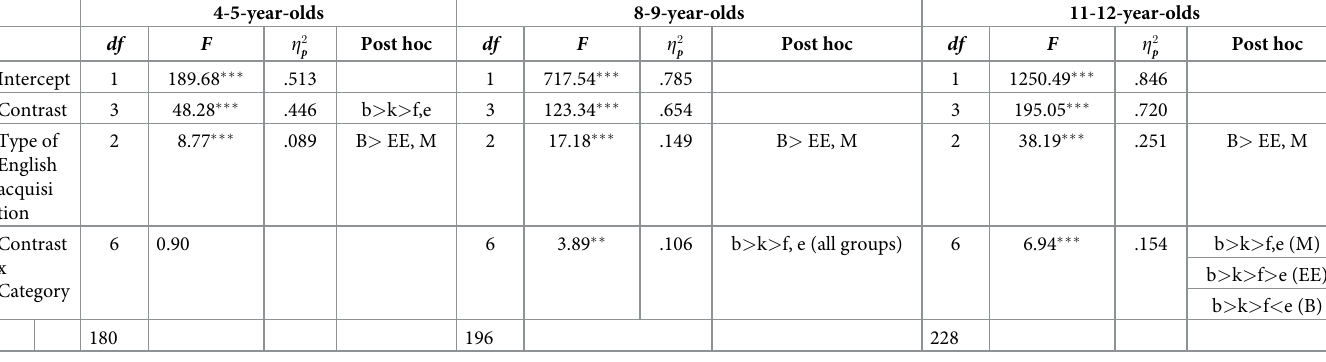
Table 3. ANOVA on d’ scores by contrast (Within-subject) and type of English acquisition (Between-subject).